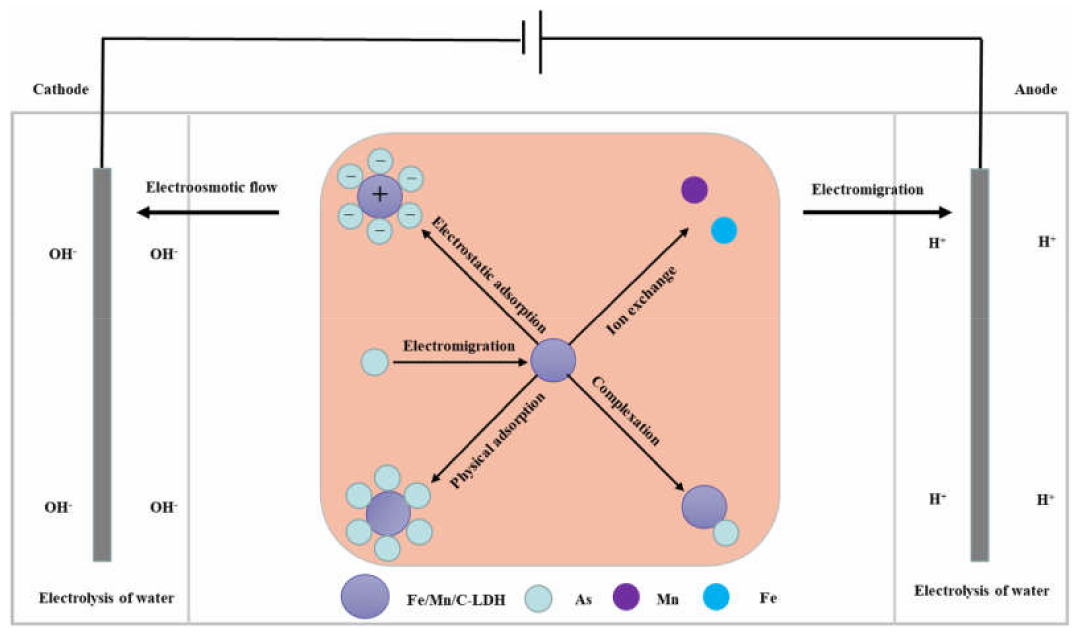
Figure 9. Schematic diagrams of arsenic removal mechanisms by